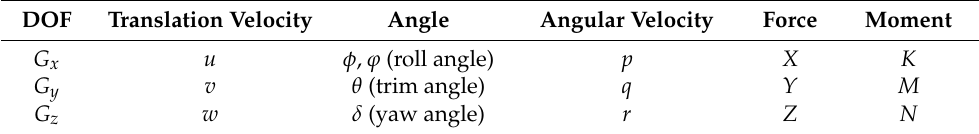
Table 2. The expressions of physical quantities of various motion forms. DOF Translation Velocity Angle Angular Velocity Force Moment G